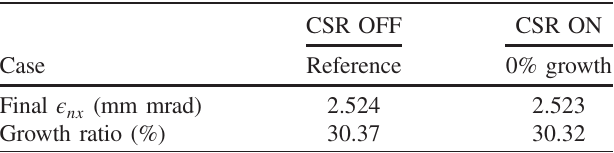
TABLE V. Final normalized emittance from the 5 m plasma source. The ratio was calculated with respect to the initial emittance of 1.936 mm